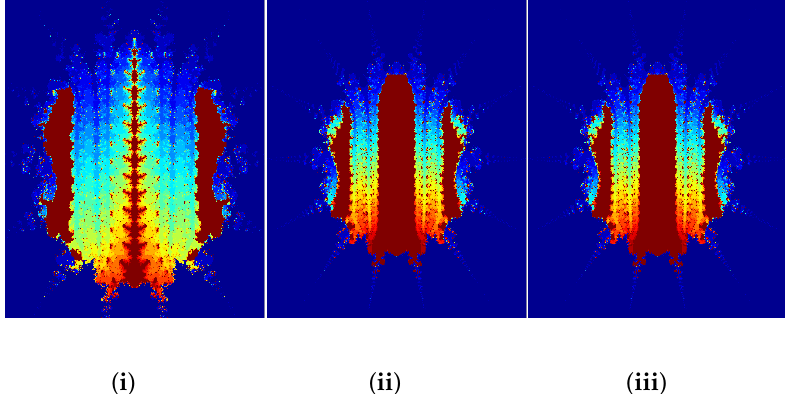
Figure 7. Septic Julia sets in ( i ) Noor-orbit; ( ii ) Ishikawa-orbit; ( iii )